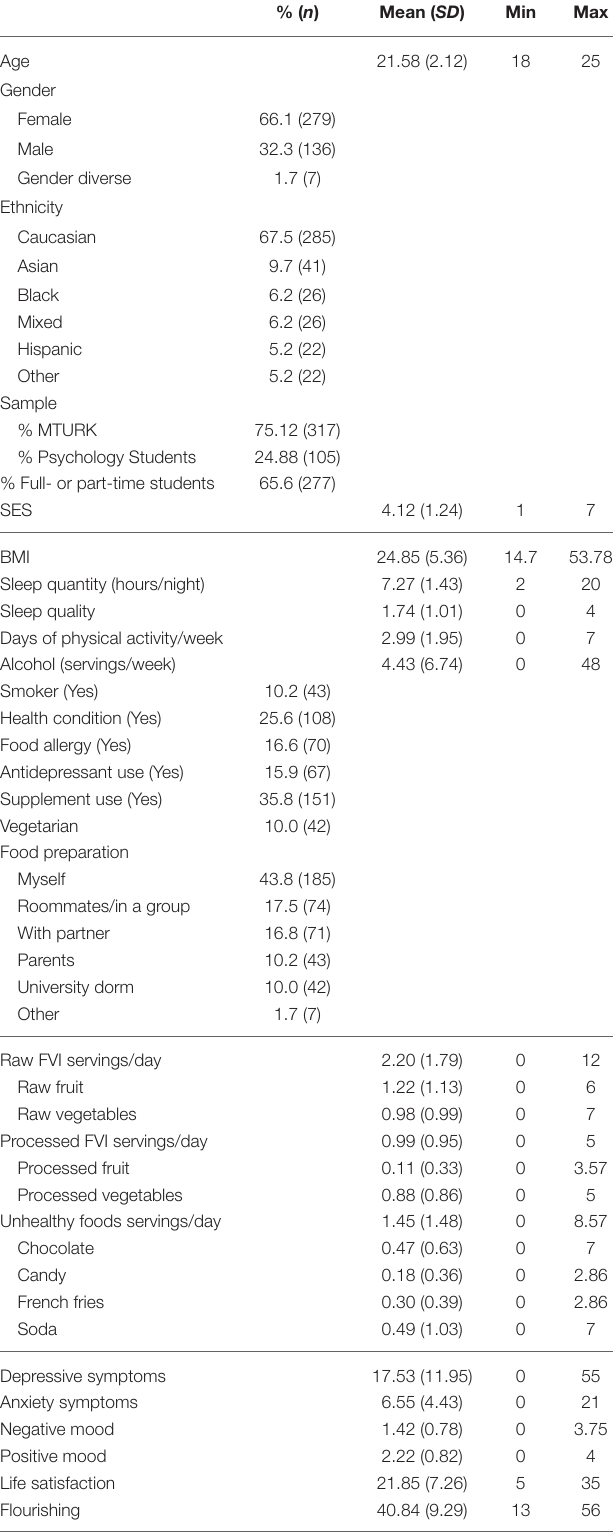
TABLE 1 | Descriptive Statistics for the Sample ( n =